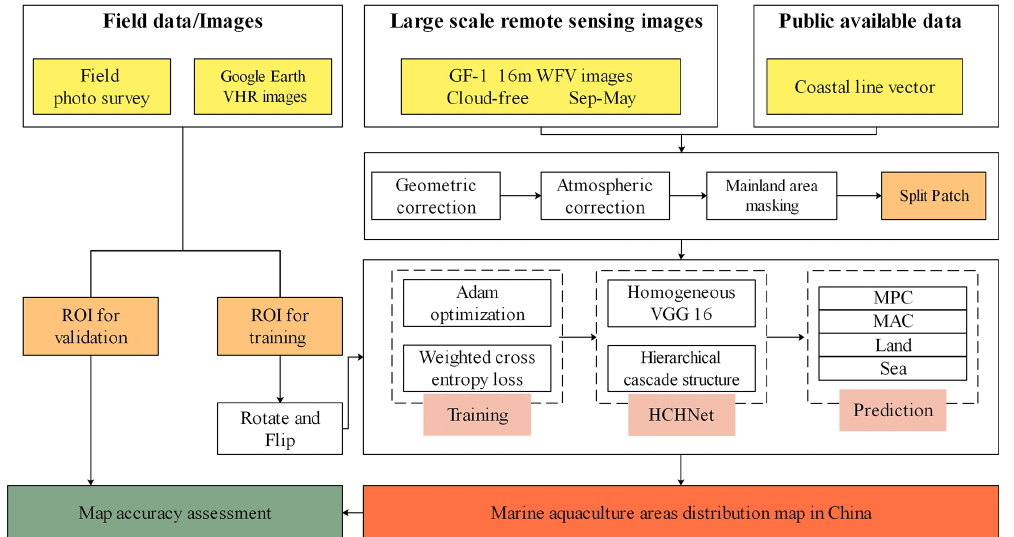
Figure 3. Schematic flow chart of the marine aquaculture mapping (ROI: region of interest; HCHNet: hierarchical cascade homogeneous neural network).